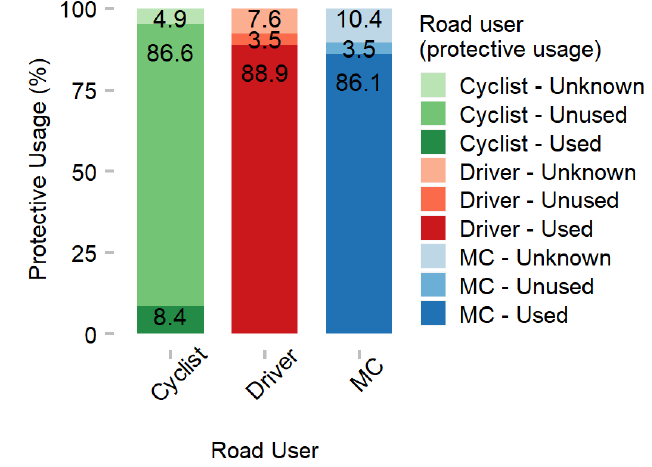
Figure 3. Use of protective equipment for cyclists, car drivers, and motorcyclists (MC)